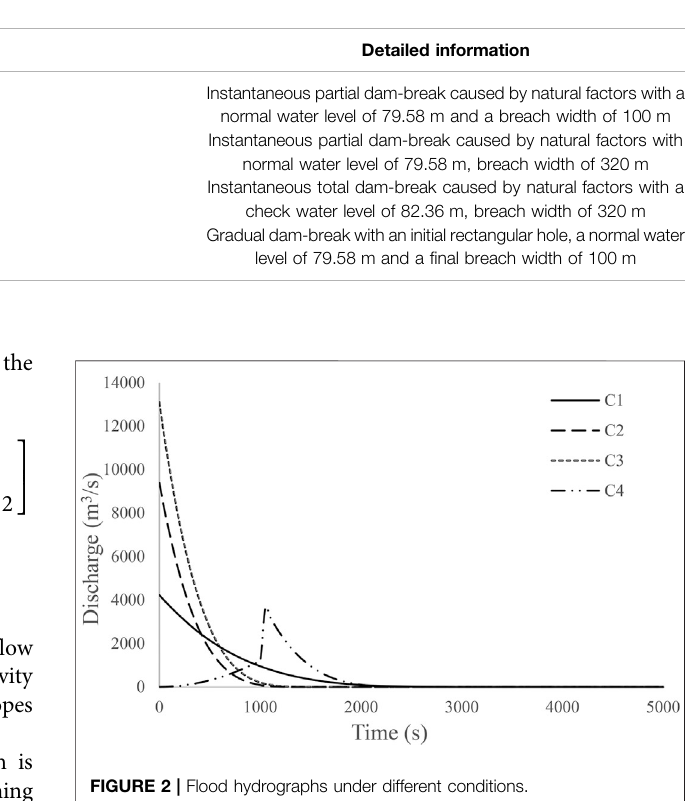
FIGURE 2 | Flood hydrographs under different